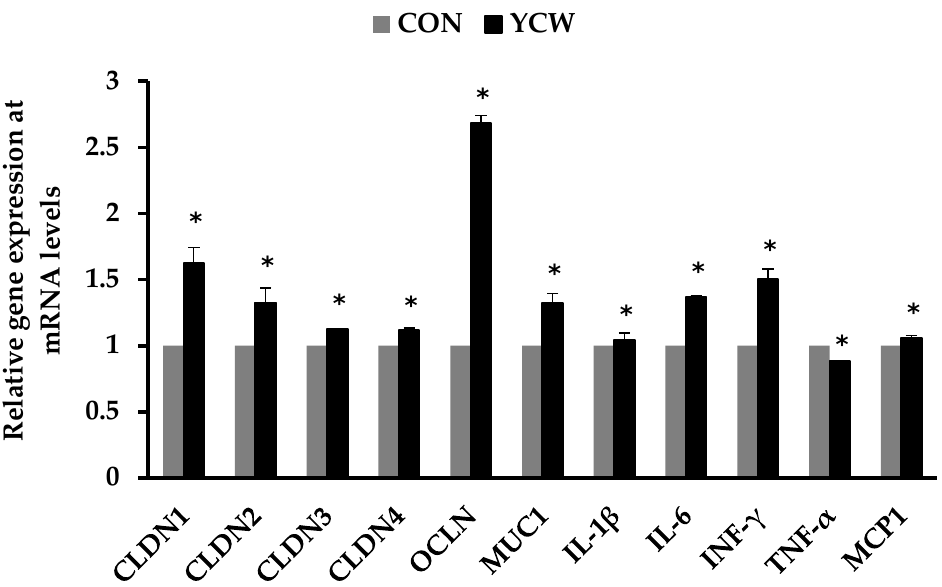
Figure 1. Relative gene expression levels of tight junction proteins and inflammatory cytokines in the ileal tissue of weaned pigs. n = 7. CON = a basal diet; YCW = CON with 0.05% dietary yeast cell wall; CLDN1 = claudin-1; CLDN2 = claudin-2; CLDN3 = claudin-3; CLDN4 = claudin-4; OCLN = occludin; MUC1 = mucin 1; IL-1 β = interleukin-1 β ; IL-6 = interleukin-6; INF- γ = interferon- γ ; TNF- α = tumor necrosis factor- α ; MCP1 = monocyte chemoattractant protein 1. Data were analyzed by t-tests. * Different between CON and YCW ( p < 0.05).